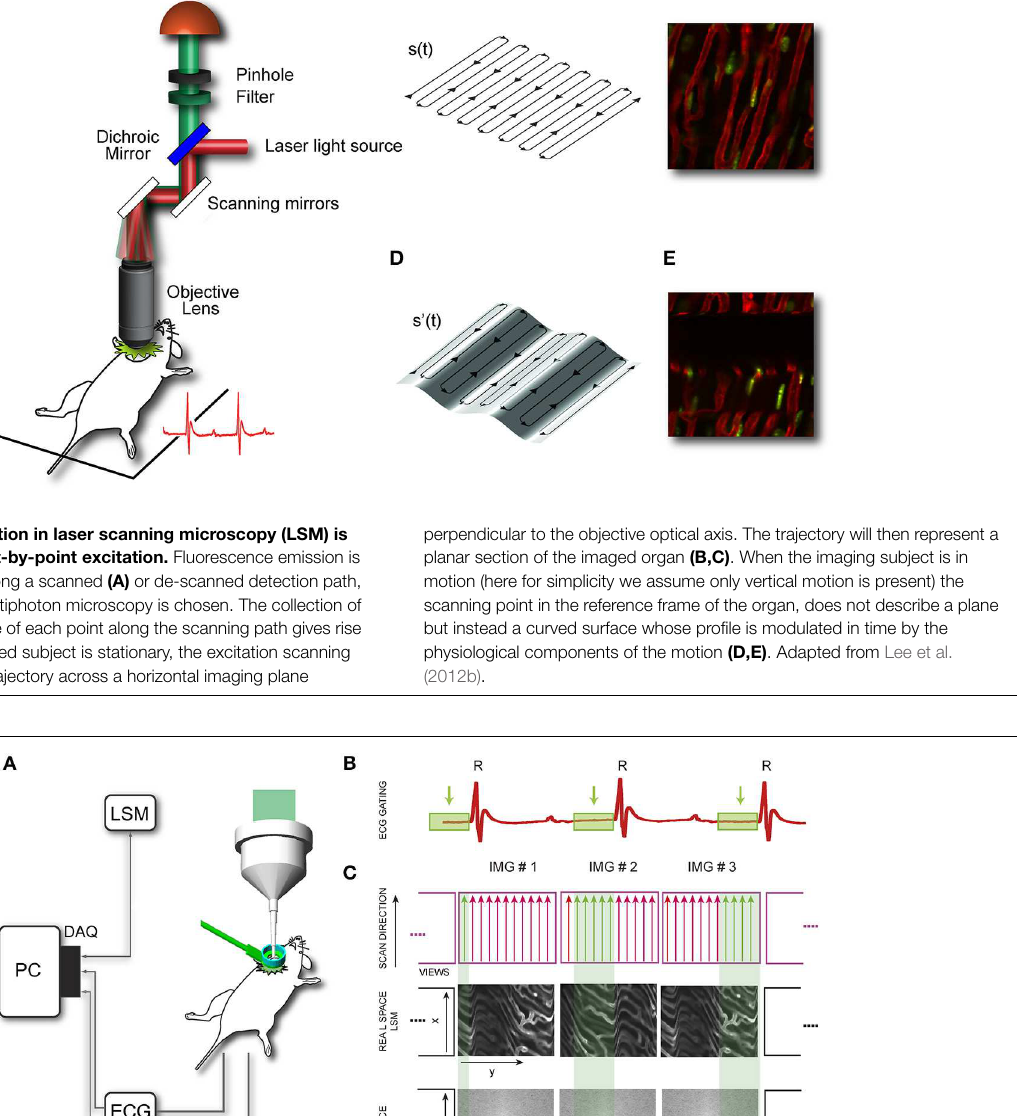
FIGURE 5 | Scheme of principle for motion compensation in laser scanning microscopy (LSM). (A) DAQ, data acquisition card; ECG, electro-cardiogram; V, mechanical ventilator. (B) Time-gated windows, coincident with the time window corresponding to the end-diastole, are isolated in the recorded ECG. (C) In LSM images are acquired pixel by pixel in the real space, with the excitation scanning laser beam moving